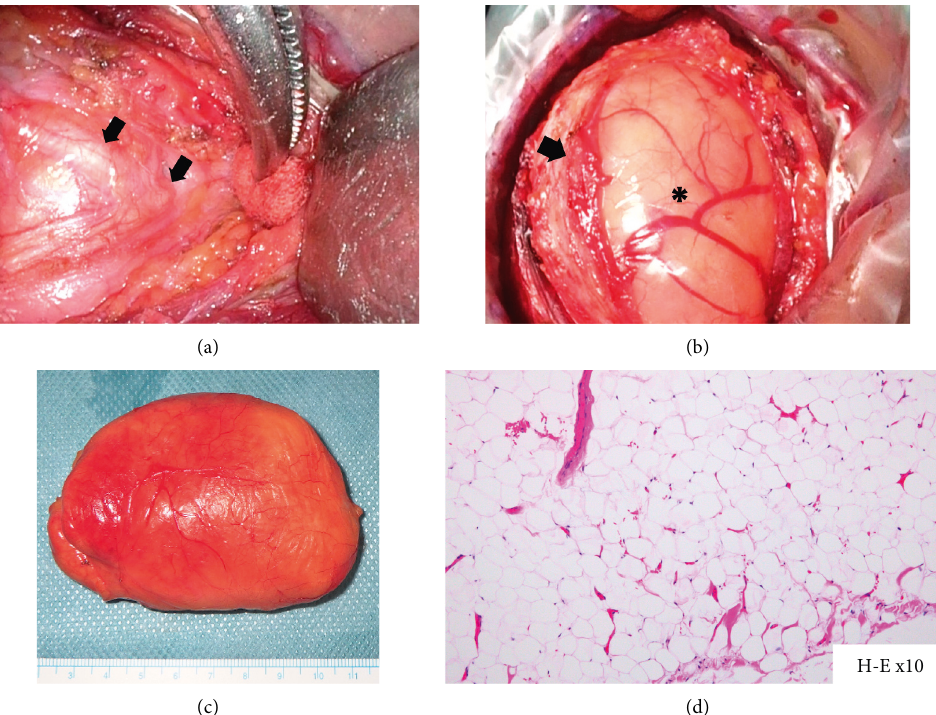
Figure 3: Intraoperative findings: the nerve of origin at the lower edge of the tumor ((a) arrow) and tumor in the neuroepithelium (arrow, epineurium; (b) ∗ , tumor) were visible. The excised yellowish specimen was 85 × 50 × 35mm (c). Histopathologically, bifurcated growth of mature adipocytes with sparse fibrous septa was observed (d) (H&E